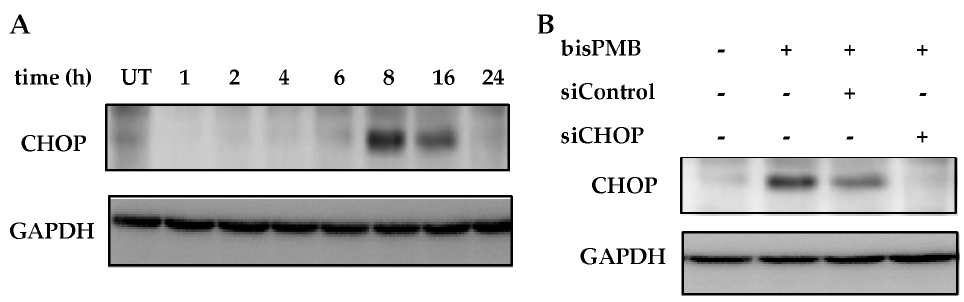
Figure 4. Figure 4. Cont.